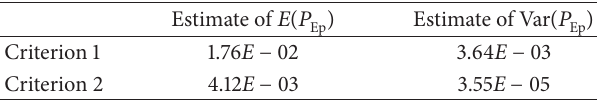
Table 2: Estimates of the expectation 𝐸(𝑃 ) of the epistemic probability 𝑃 Var (𝑃 Ep